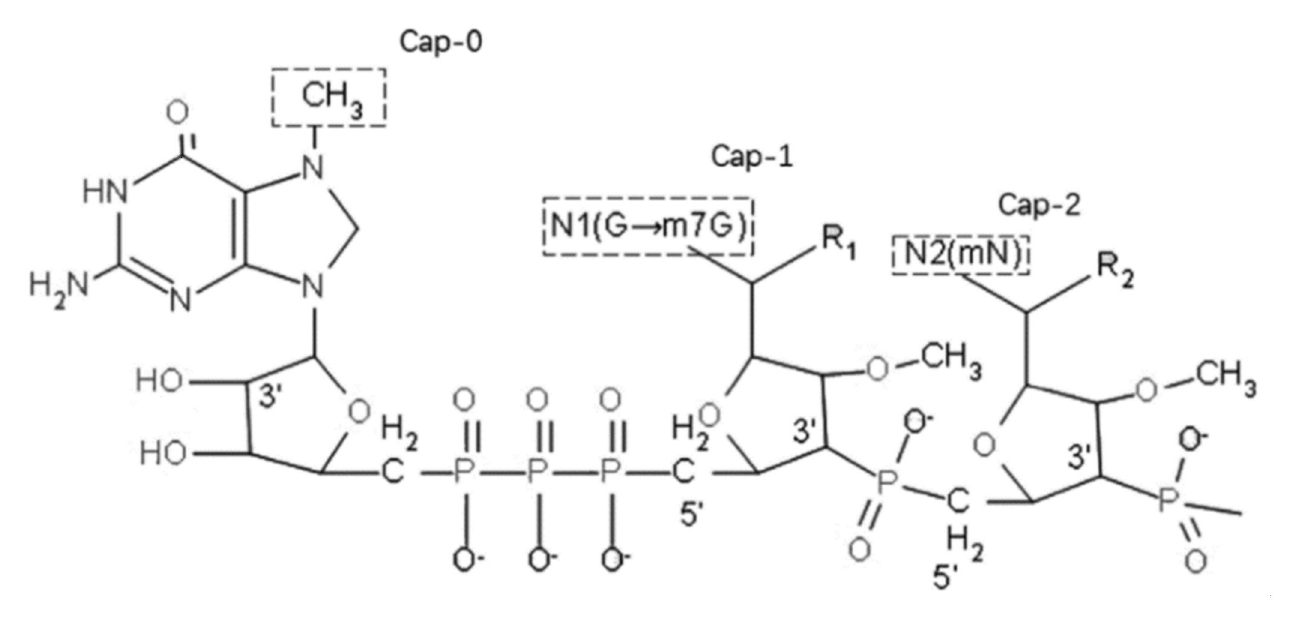
Figure 4. The structure of the 5 (cid:48) -cap (cited from [43]). The first nucleoside in the 5 (cid:48) -cap is usually composed of a guanine methylated at the seventh position and a ribosome (m7G). m7G is connected to the terminal nucleotide of the mRNA through a phosphate bond. The following first or second nucleotide can also be methylated at the 2 (cid:48) hydroxyl group of the ribose. Type O (m7G5 (cid:48) ppp5 (cid:48) Np) has an unmethylated ribose; type I (m7G5 (cid:48) ppp5 (cid:48) NmpNp) has a methylated ribose in the first nucleotide at the terminus; and in type II (m7G5 (cid:48) ppp5 (cid:48) NmpNmp), both nucleotides are